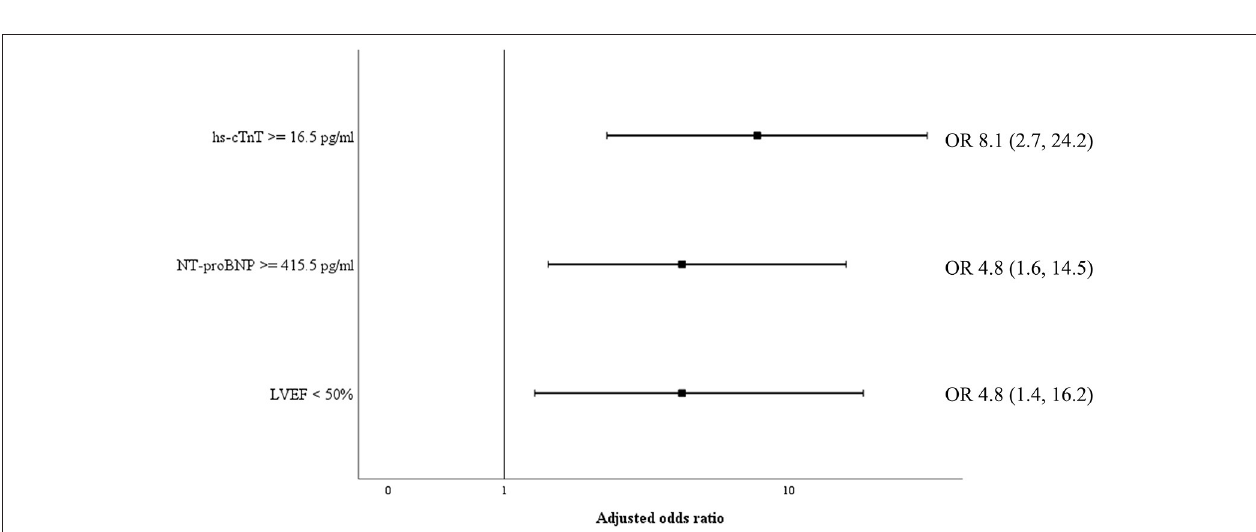
FIGURE 5 | Adjusted odds ratio for 30-day all-cause mortality. Odds ratio for 30-day all-cause mortality, adjusted for SOFA-score, for cardiac biomarkers hs-cTnT and NT-proBNP as well as reduced left ventricular ejection fraction. NT-proBNP, N-terminal pro-brain natriuretic peptide; hs-cTnT, high sensitive troponin T. LVEF, left ventricular ejection fraction; OR, odds